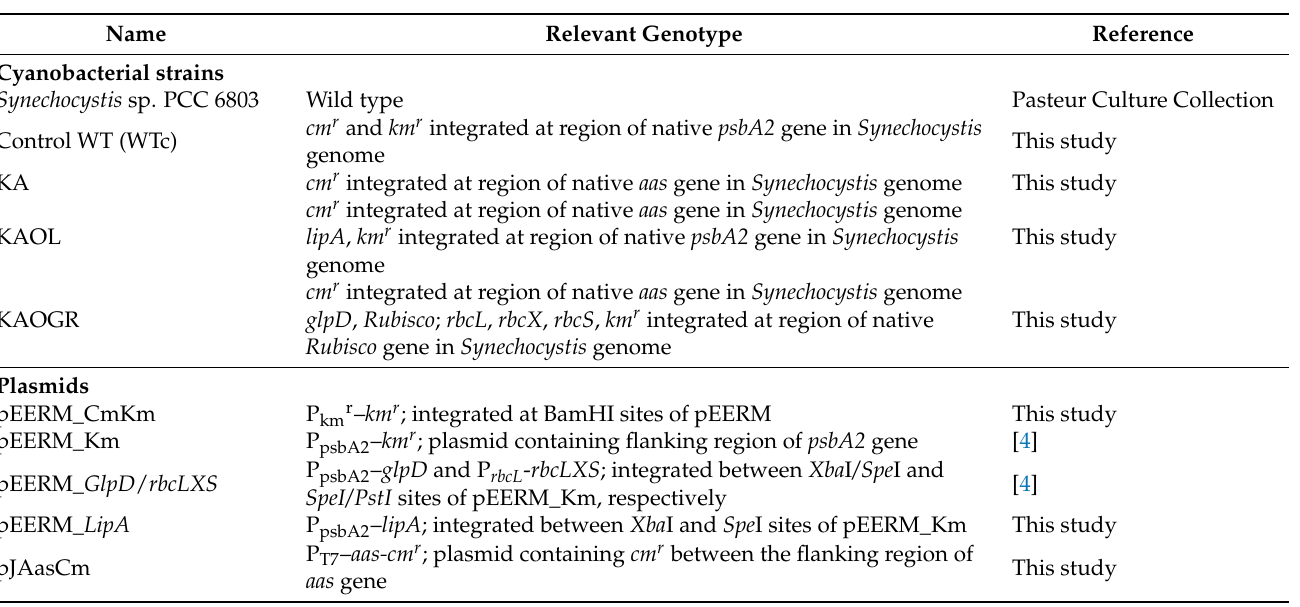
Table 1. Strains and plasmids used in this